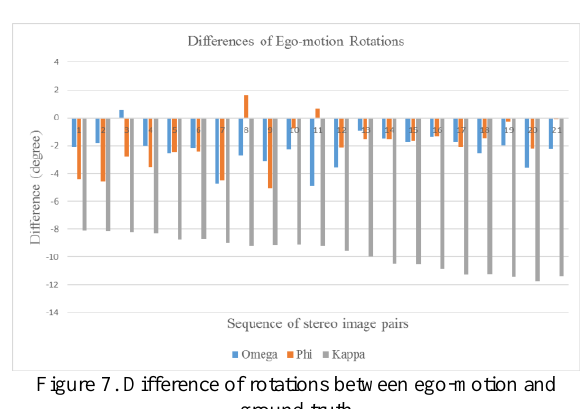
Figure 7. Difference of rotations between ego-motion and ground truth